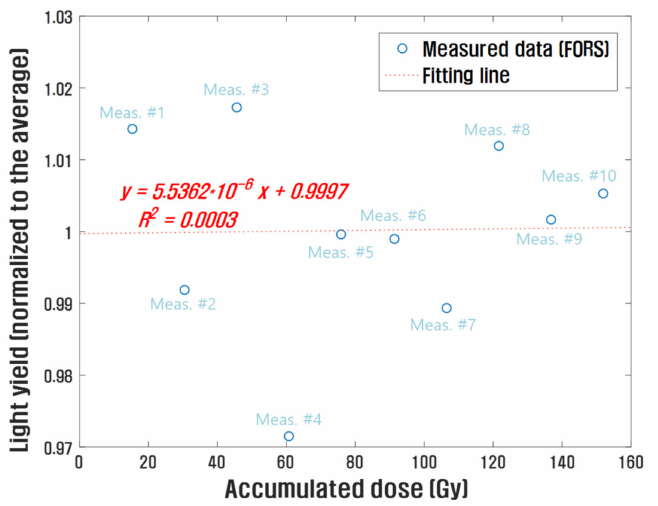
Figure 5. Fluctuation of the measured scintillation generated in the FORS.